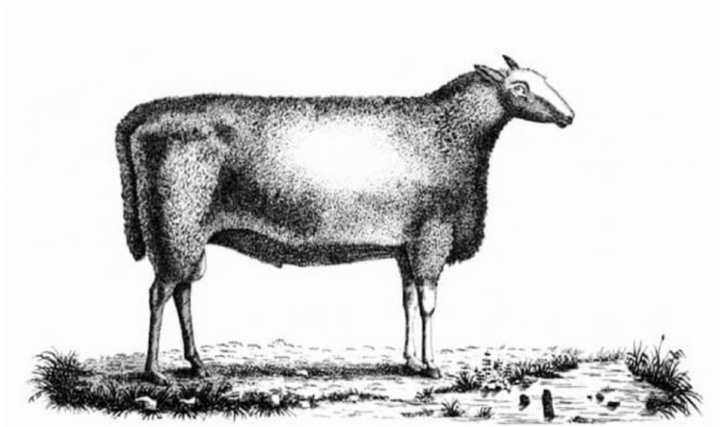
Figure 3. A freshly shorn Dishley ram from ONV 1825 Nr.45. Moravian breeders regarded Robert Bakewell’s sheep race as an example applying